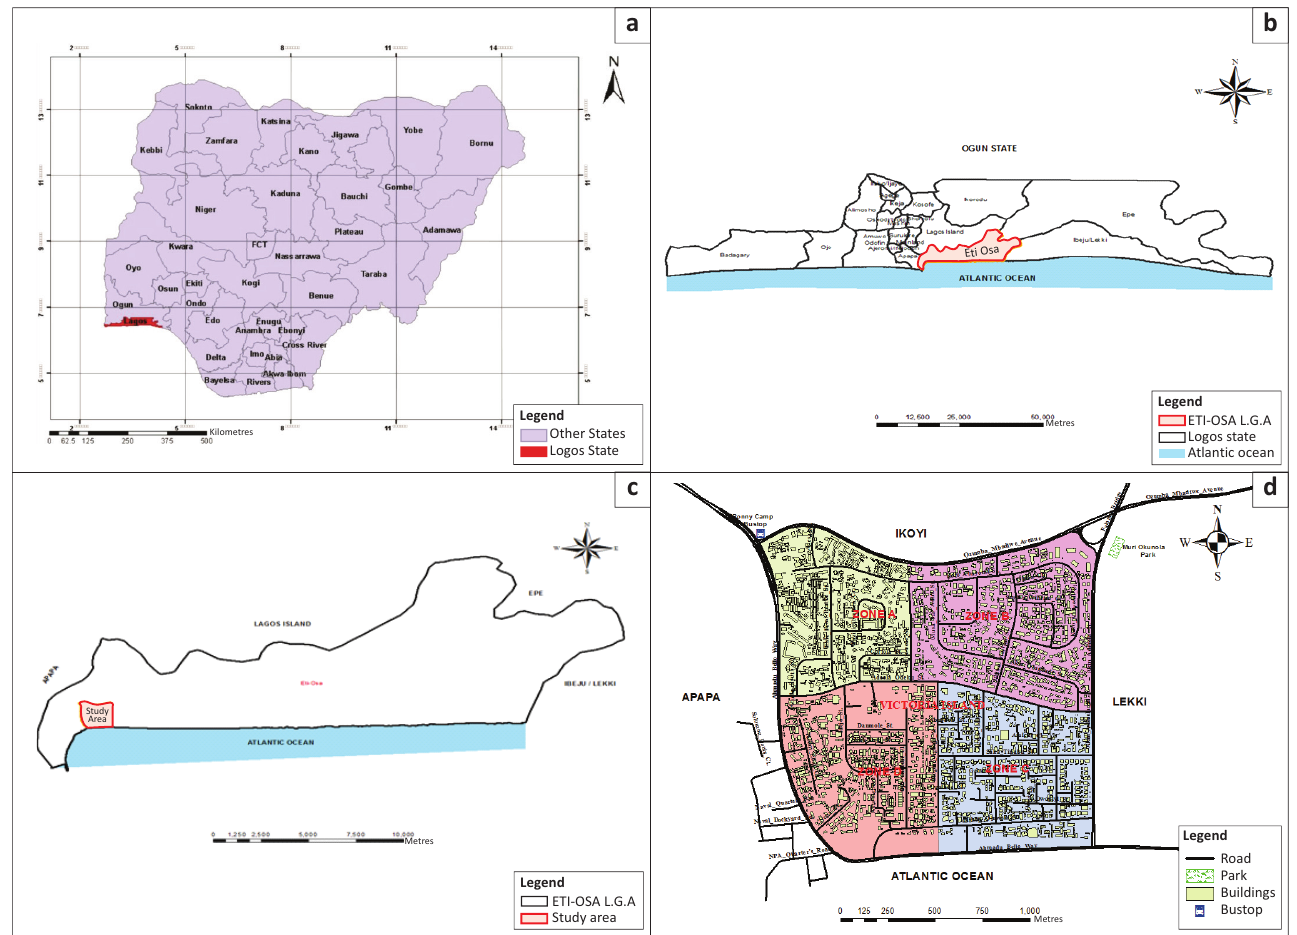
FIGURE 2: Victoria Island in Eti-Osa LGA Lagos,